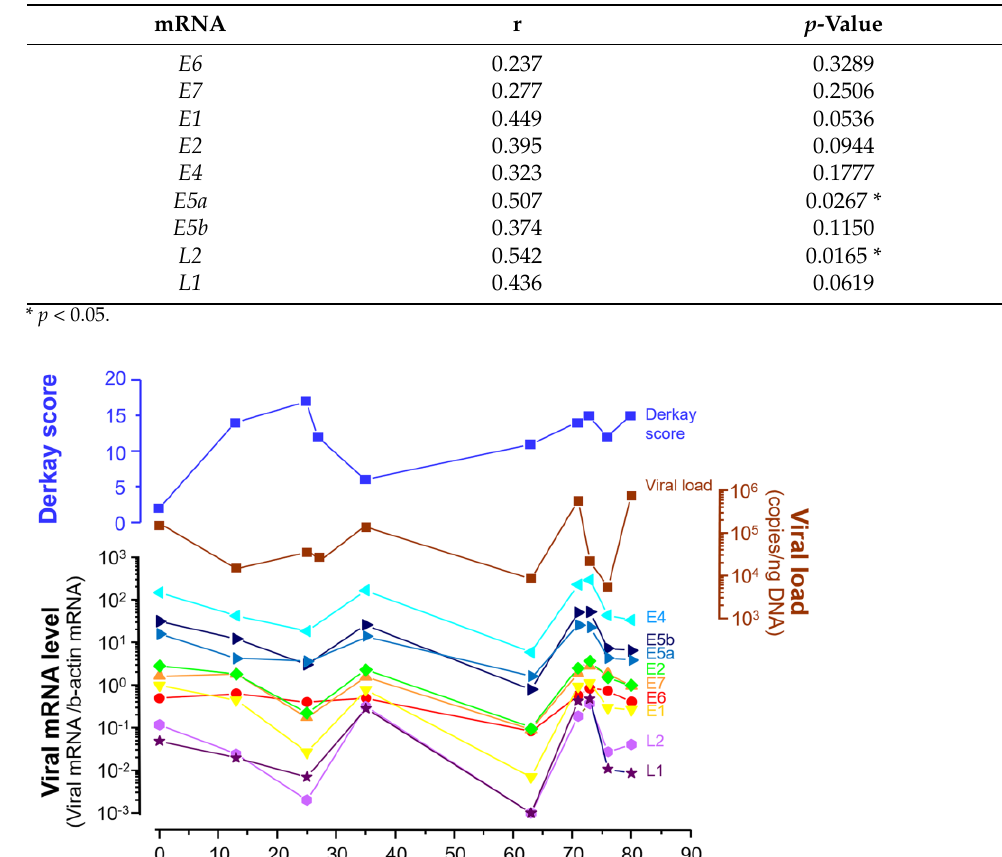
Table 5. Correlation coefficients between the levels of the 9 viral mRNAs and viral load in HPV-6- related LP.